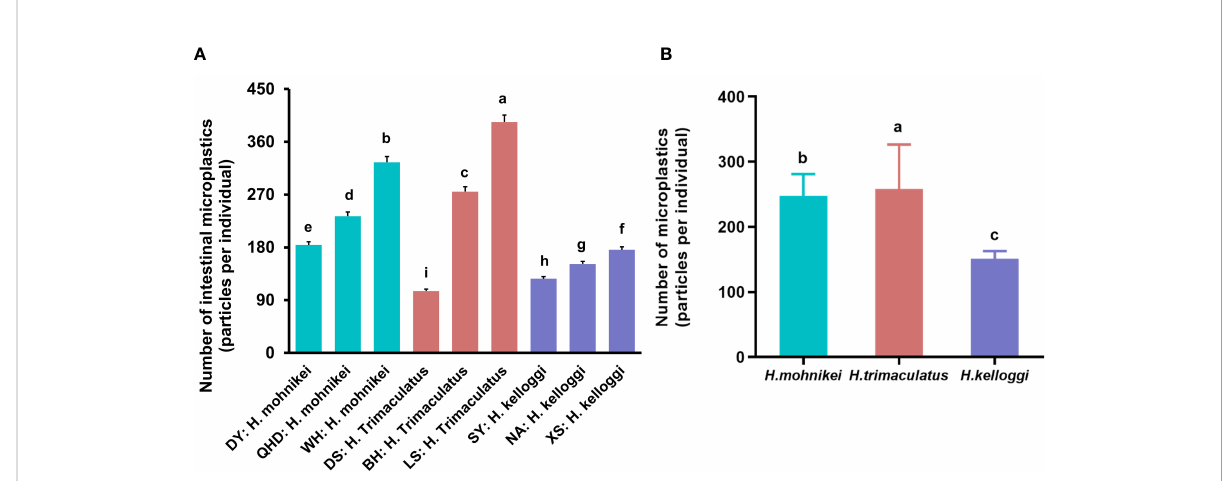
FIGURE 5 Microplastic contents of wild seahorses from different regions (A) and in different species (B) . The same color represents the same species of seahorse. The letters in the Figure represent signi fi cant variations between species ( P <